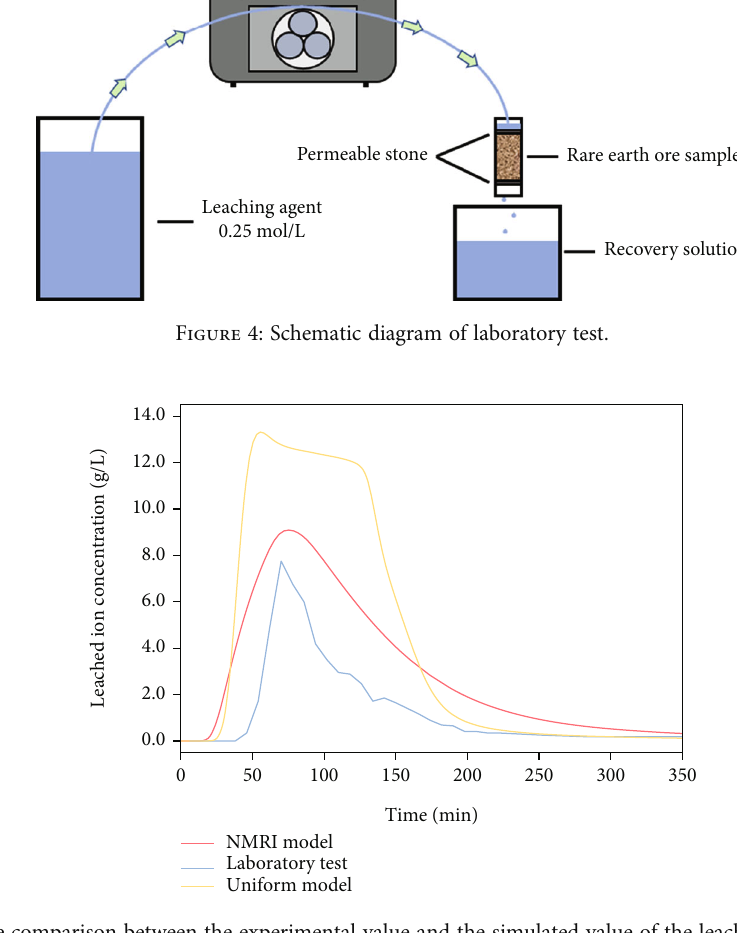
Figure 5: The comparison between the experimental value and the simulated value of the leaching concentration.